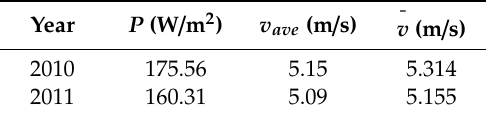
Table 2. Characteristics of the wind resource per year: average power P , average wind speed from data v ave and mean wind speed from Weibull distribution v .